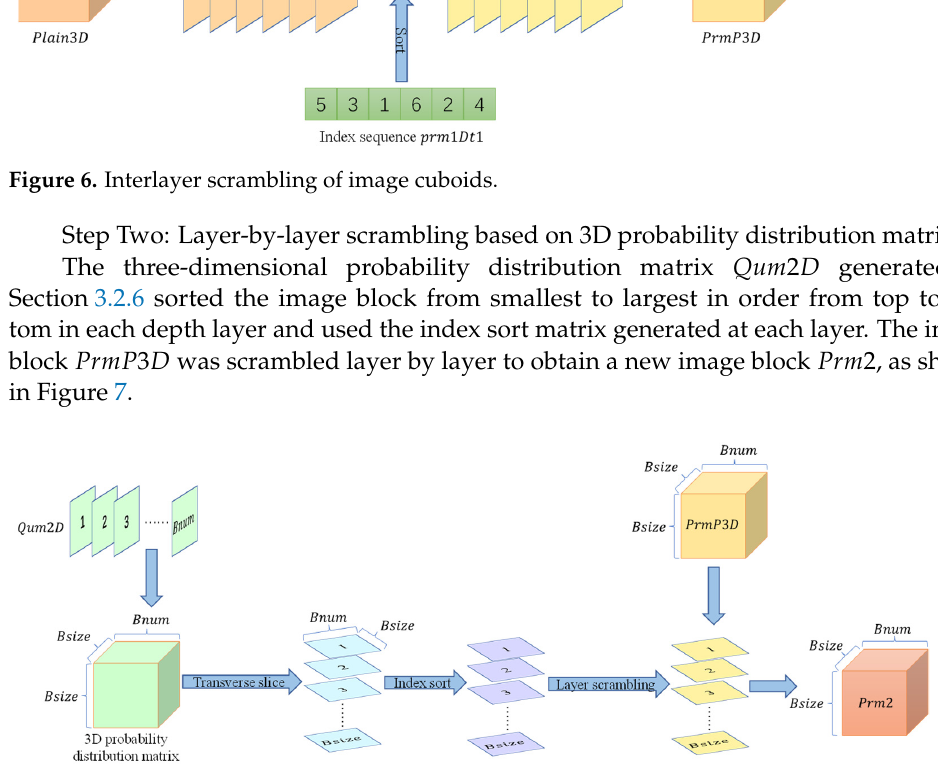
Figure 5. Generation of index sequence 𝑝𝑟𝑚 1 𝐷𝑡 . Figure 6. Interlayer scrambling of image cuboids.